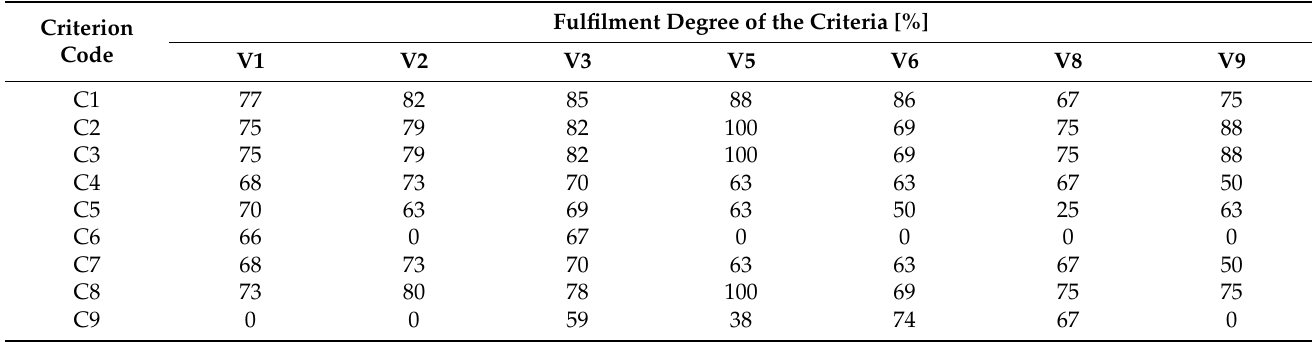
Table 5. Assessment of the fulfilment degree of the criteria by each